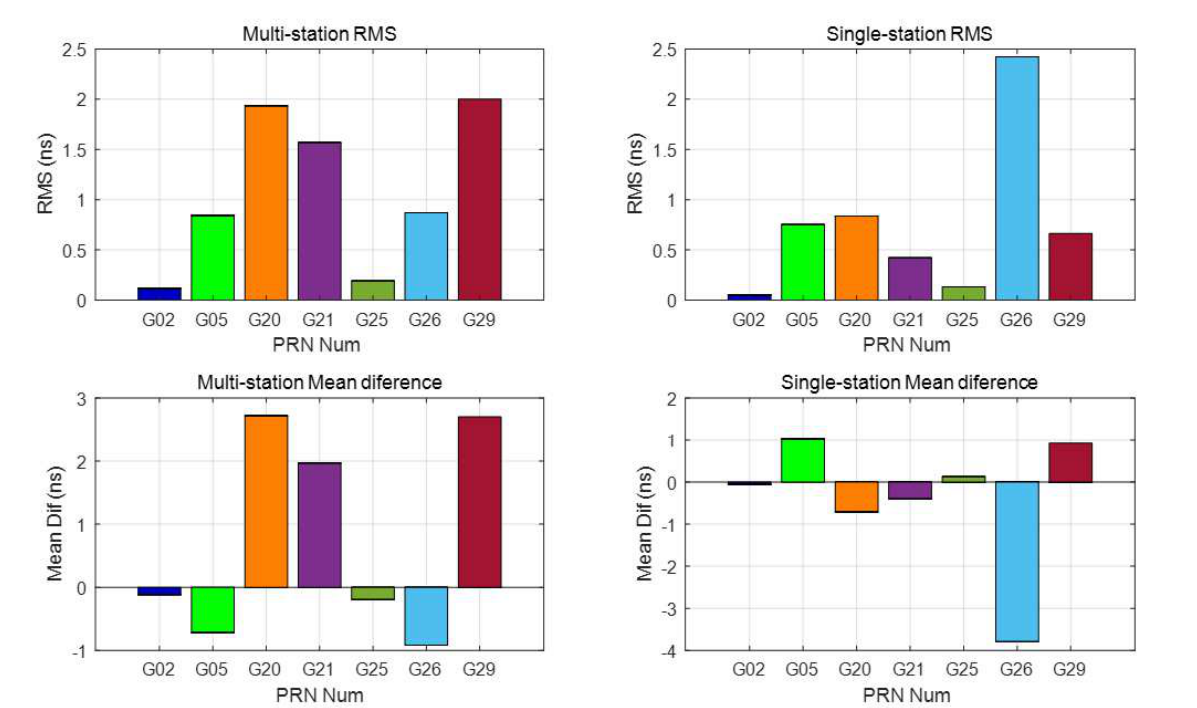
Figure 6. RMS and the mean difference between multi-station ( left 2 plot) and single-station ( right 2 plot) short period (15 min) estimated satellite DCBs and CODE products for 21:19–21:34, 16 August